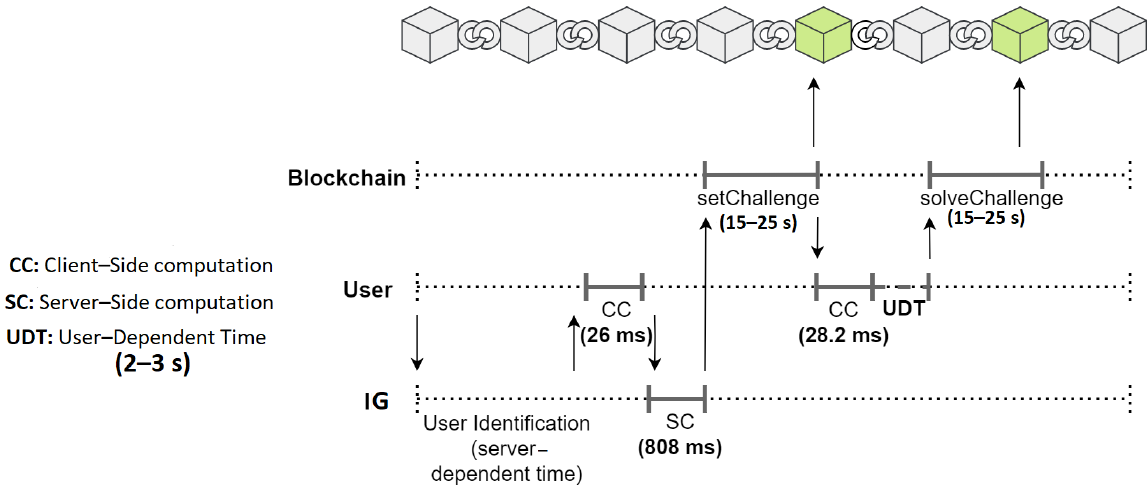
Figure 12. Timeline of the interactions between user, IG , and blockchain.